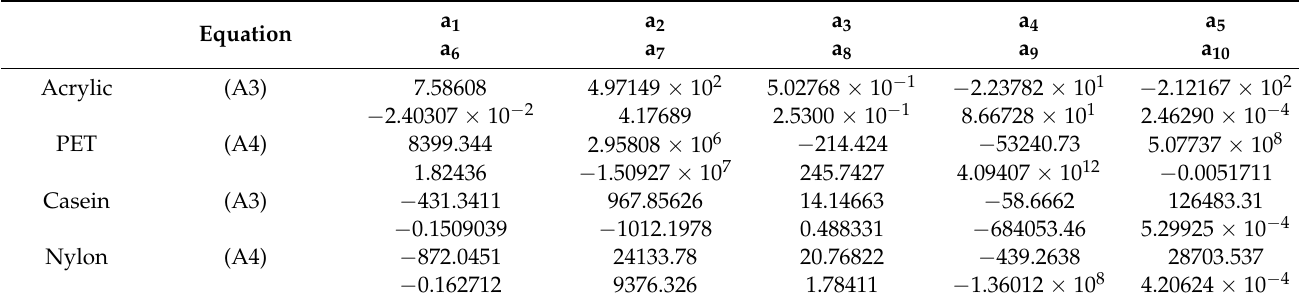
Table A2. Parameters of regression equations a